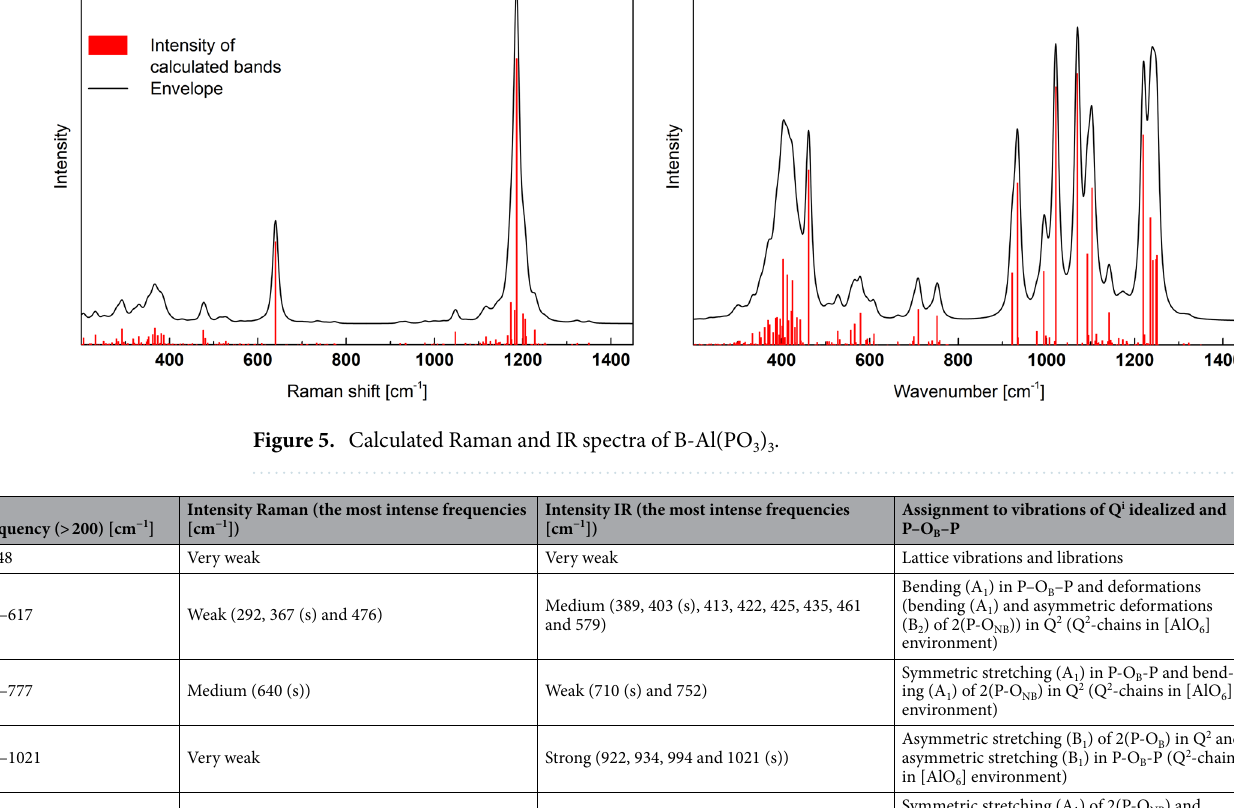
Table 2. Calculated Raman and IR active modes of B-Al(PO 3 ) 3 (more details in the supplementary materials Table S1.2). s—the strongest in range.